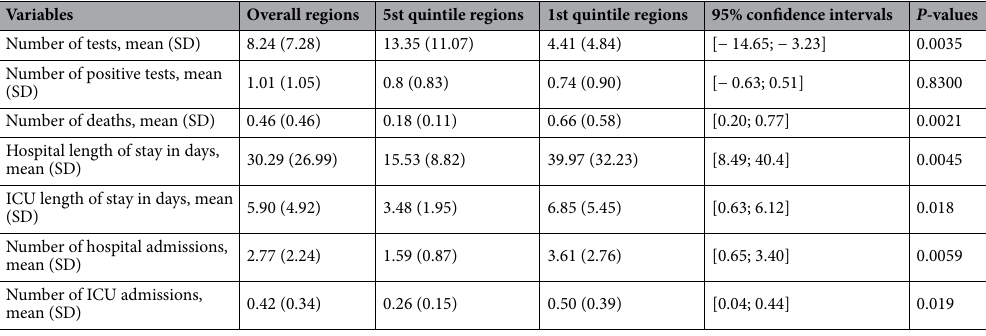
Table 1. Number of SARS-CoV2 tests, deaths, hospital and ICU admissions in metropolitan regions, France, March–May 2020 (n = 12). Sample means and standard deviations (SD) are reported for all French departments and those for 5th and 1st quintile regions. Values are reported per 100,000 inhabitants-day and computed for each department. Confidence intervals and p-values are calculated at a 95% confidence level for the 1st and the 5th quintile for means comparison using Student’s t-test. Quintiles are computed on the basis of the average number of RT-PCR tests divided by the number of patients admitted to the hospital for COVID-